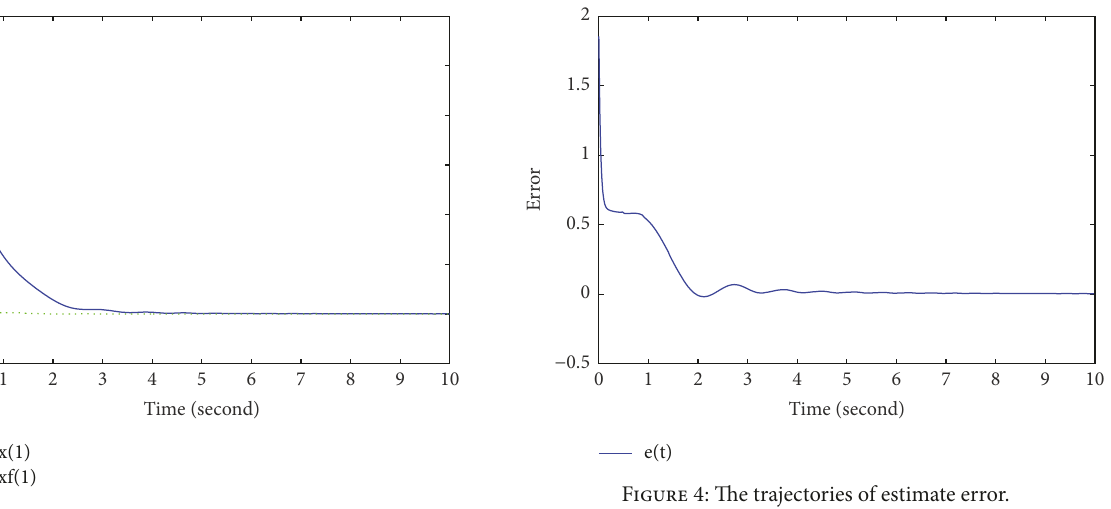
Figure 1: State trajectories of 𝑥 1 .